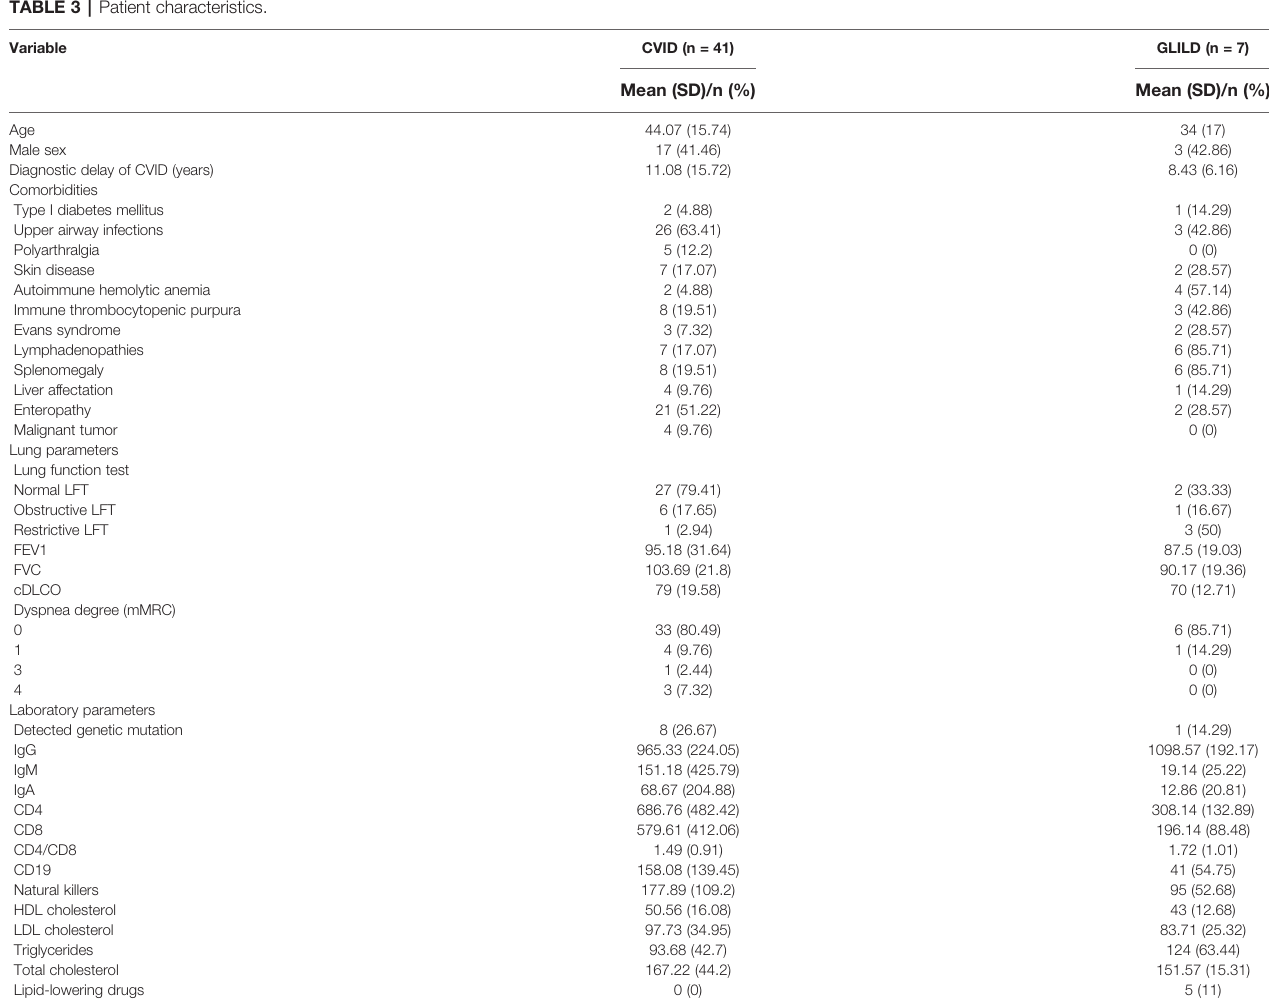
TABLE 3 | Patient